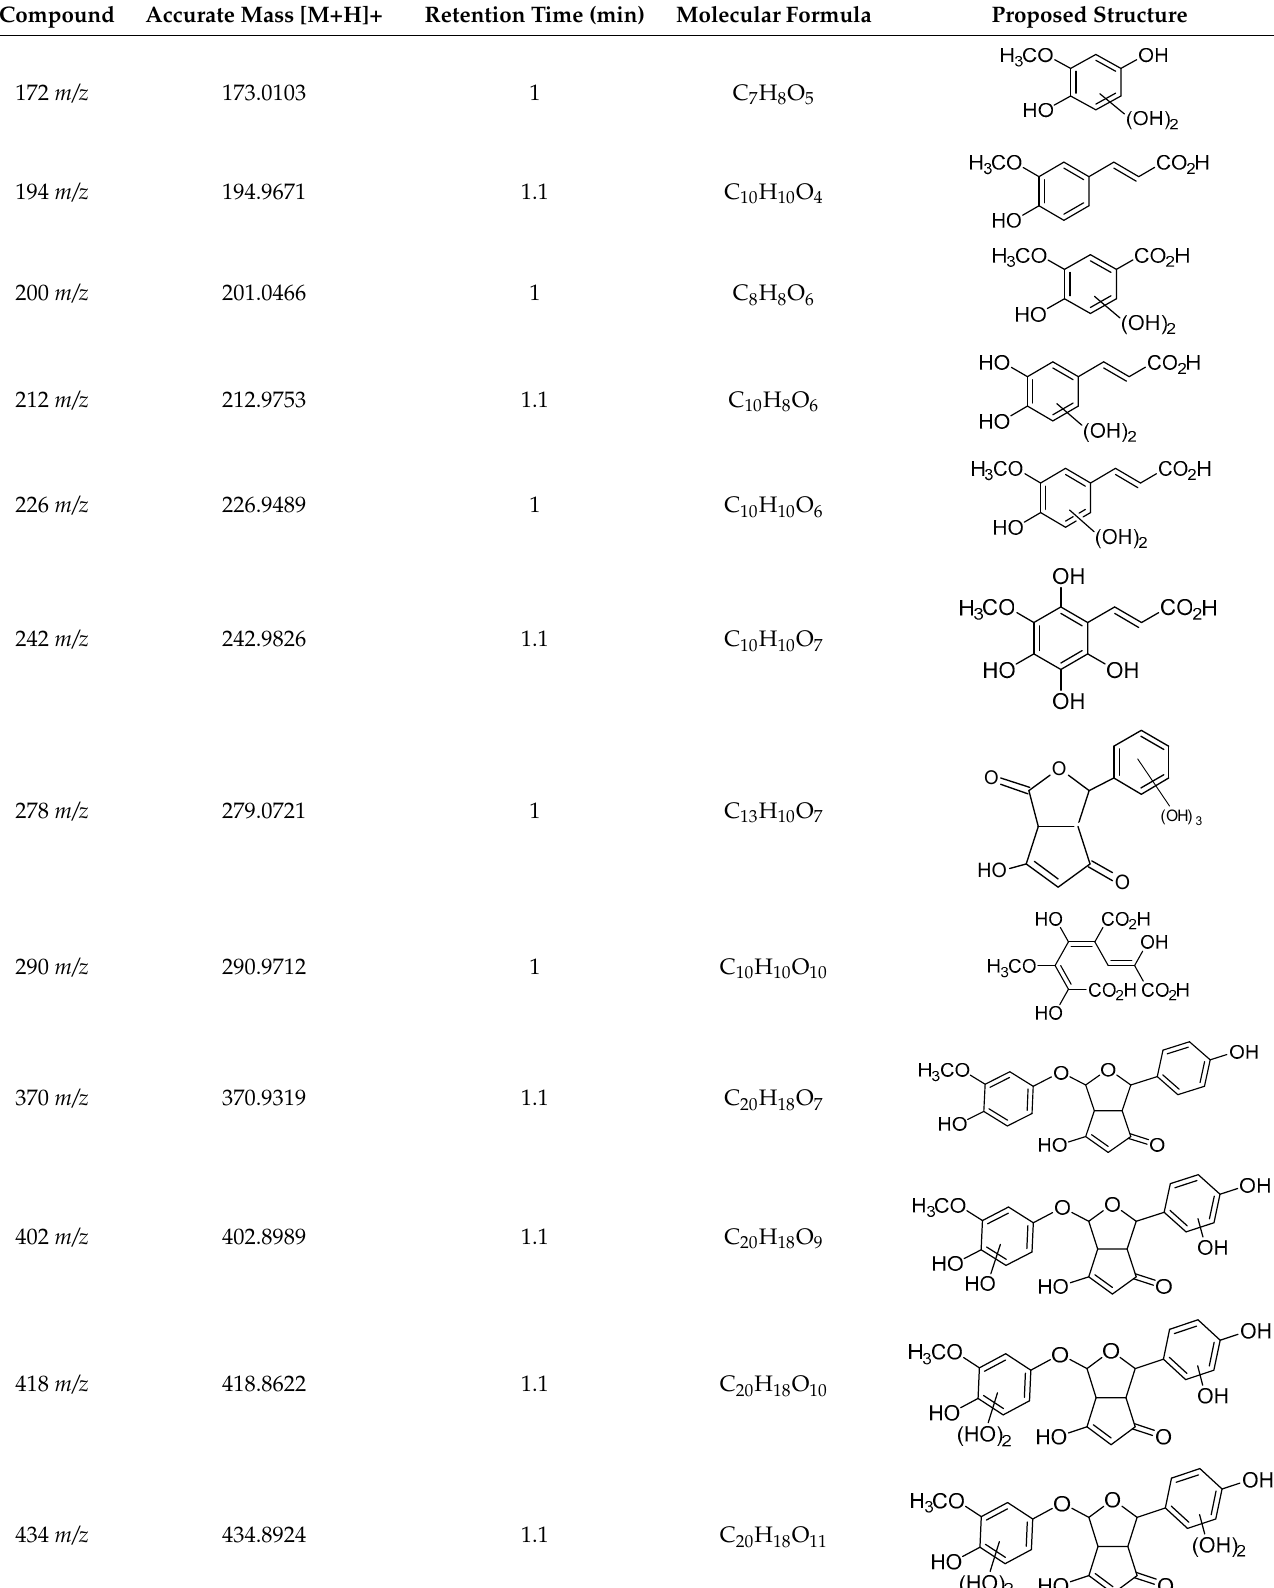
Table 1. Proposed structures of the produced byproducts obtained from direct photolysis of curcumin, molecular formulas with the respective m/z , and retention time.